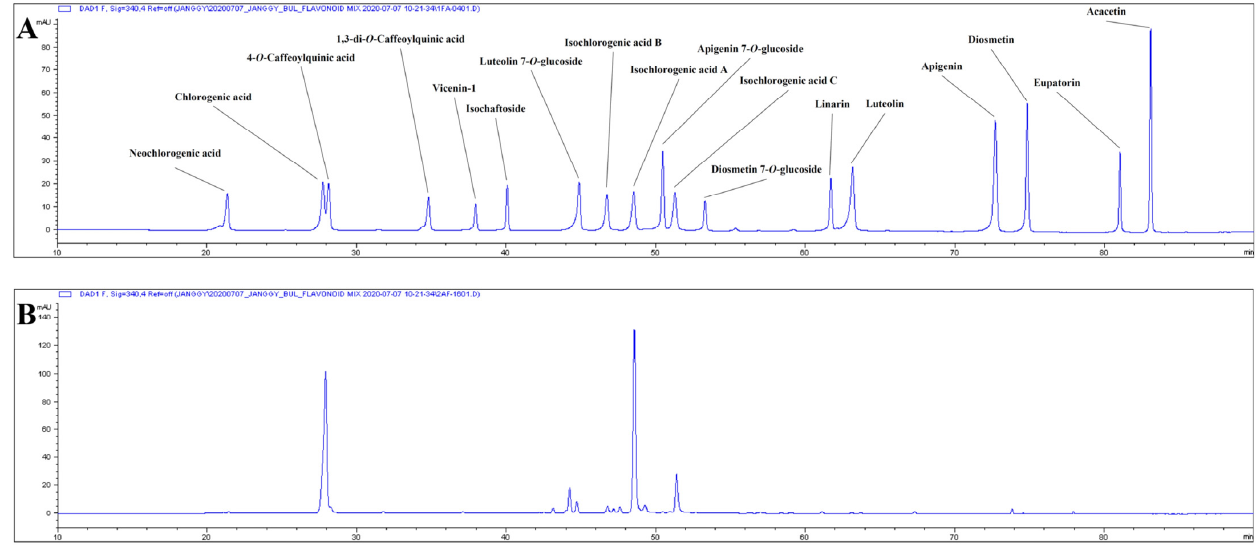
Figure 13. Typical chromatogram of AK extract. ( A ) Standard mixture, ( B ) AK extract. Standards: neochlorogenic acid, chlorogenic acid, 4- O -caffeoylquinic acid, 1,3-di- O -caffeoylquinic acid, vicenin-1, isochaftoside, luteolin 7- O -glucoside, isochlorogenic acid B, isochlorogenic acid A, apigenin 7- O -glucoside, isochlorogenic acid C, diosmetin 7- O -glucoside, linarin, luteolin, apigenin, diosmetin, eupatorin, and acacetin. Table 2. Phenolic composition of AK extract.